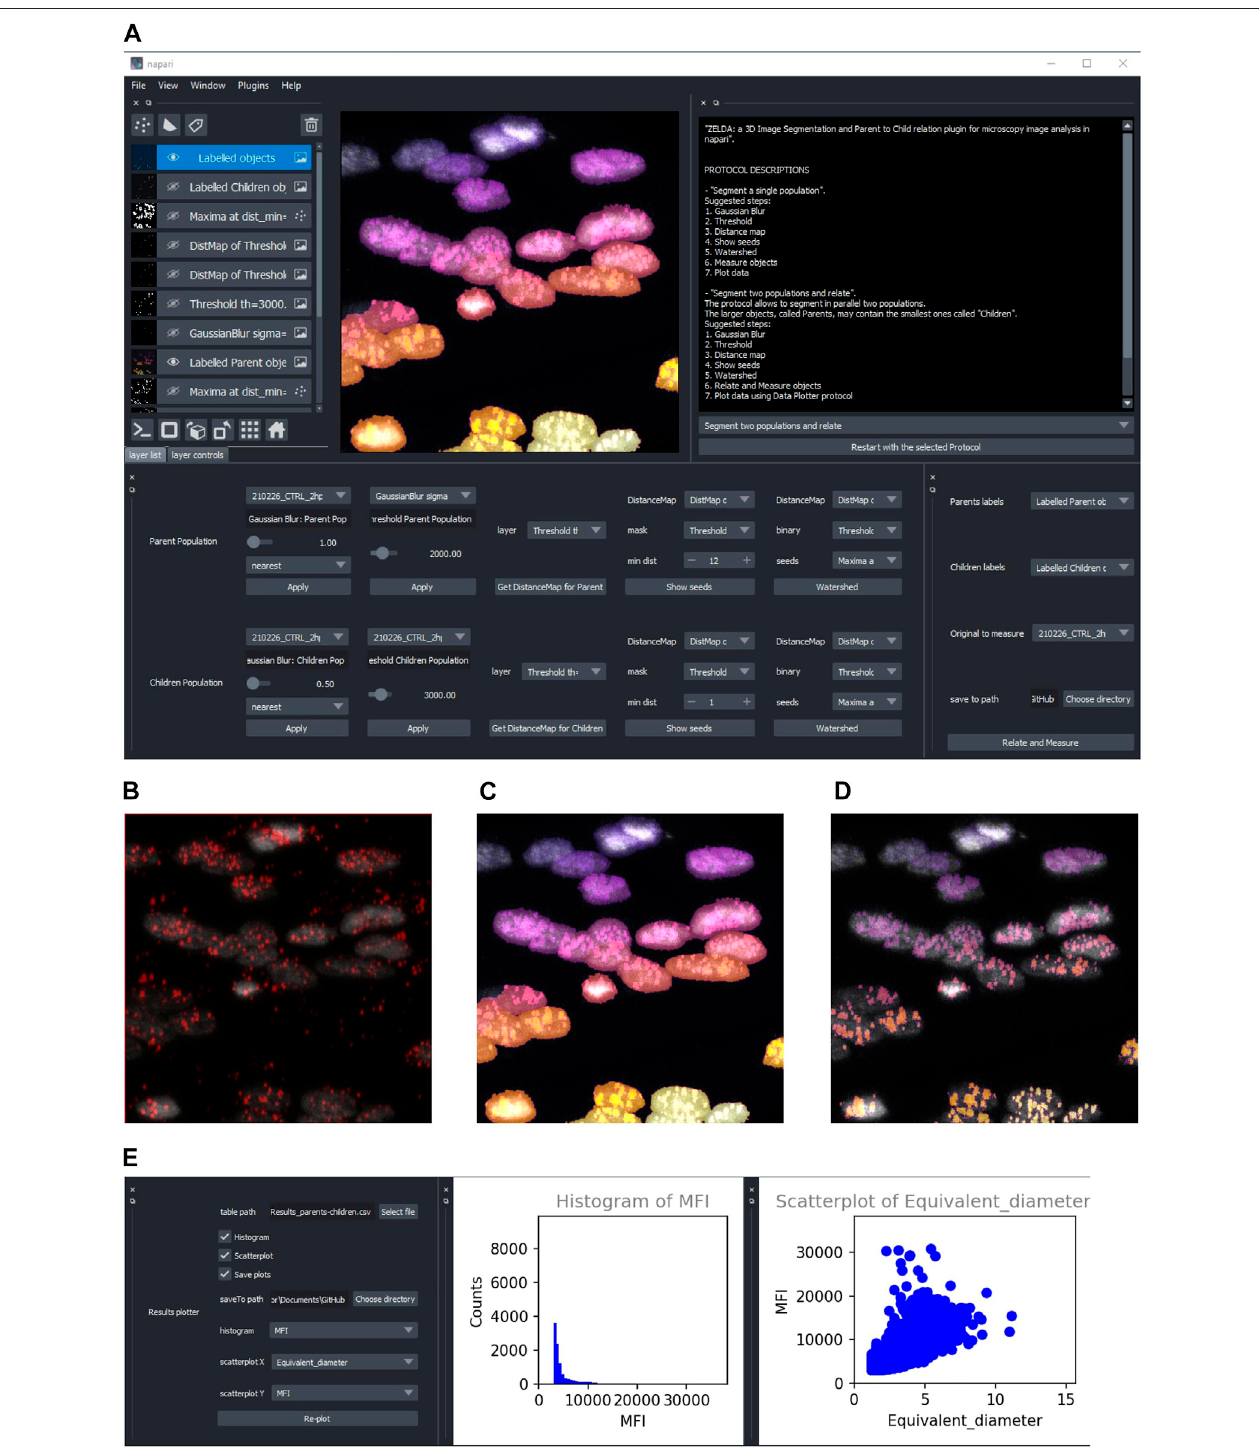
FIGURE 2 | ZELDA application for the 3D segmentation of two object populations and “ Parent-child ” relation. (A) ZELDA protocol “ Segment two populations and relate ” used toanalyze thedistribution ofviralRNAininfected humancellnuclei. (B) Original3Ddataset showinganuclear stainingwithDAPI(gray)and anRNAstaining with AlexaFluor 568 (red). (C) The nuclei and the RNA aggregates, individually segmented and (D) the RNA aggregates (children population) labelled according to the containing nuclei (parent population). (E) Resulting measurements reimported and plotted with the “ Data Plotter ” protocol.